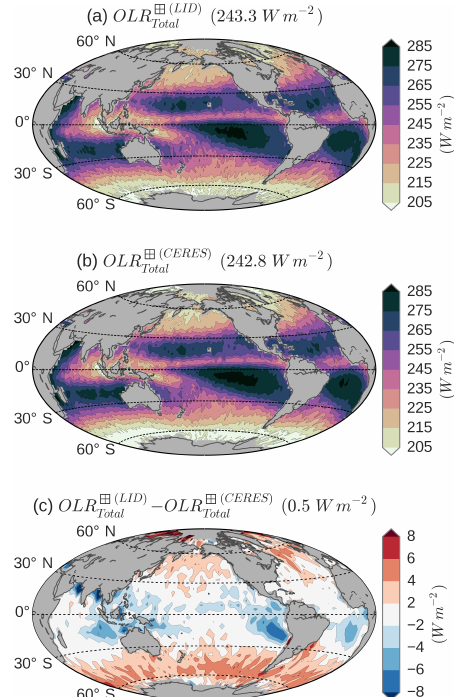
(cid:1) ( LID ) total